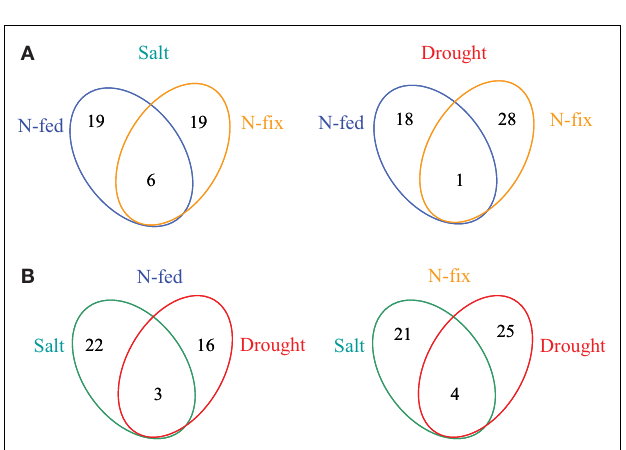
FIGURE 2 |Venn diagrams of the number of stress responsive proteins and metabolites. (A) overview of N-source depended changes for drought and salt separately; (B) overview of stress dependent overlap for N-fed (nitrogen fertilization) and N-fix (nitrogen fixation) separately.